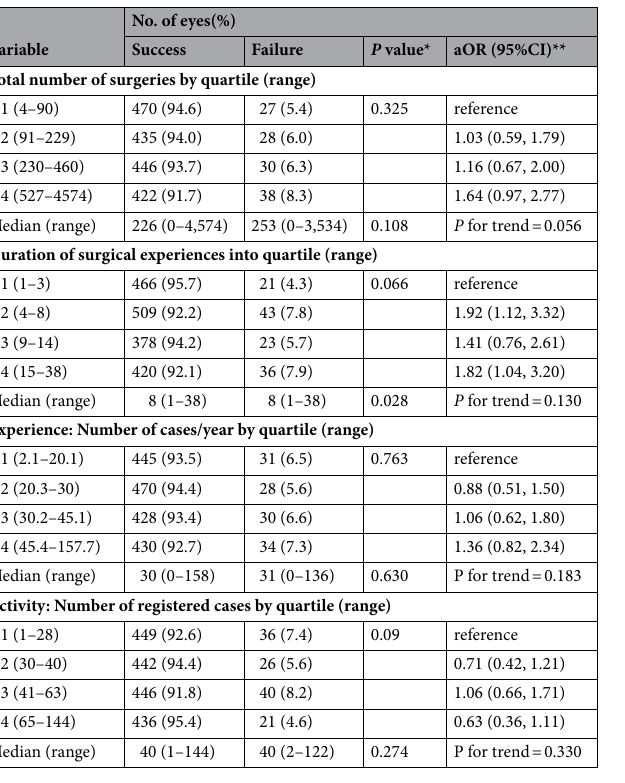
Table 1. Relationship between factors associated with surgeons’ experience and surgical outcomes in PPV cases. *Chi-square test or Mann–Whitney U test. **Adjusted odds ratio (aOR) based on multivariate logistic regression analysis. This model was adjusted for sex, age, best-corrected visual acuity, location of the largest tears or holes, presence of proliferative vitereoretinopathy (PVR; B), and intraoperative complications. PPV, pars plana vitrectomy; aOR, adjusted odds ratio; CI, confidence